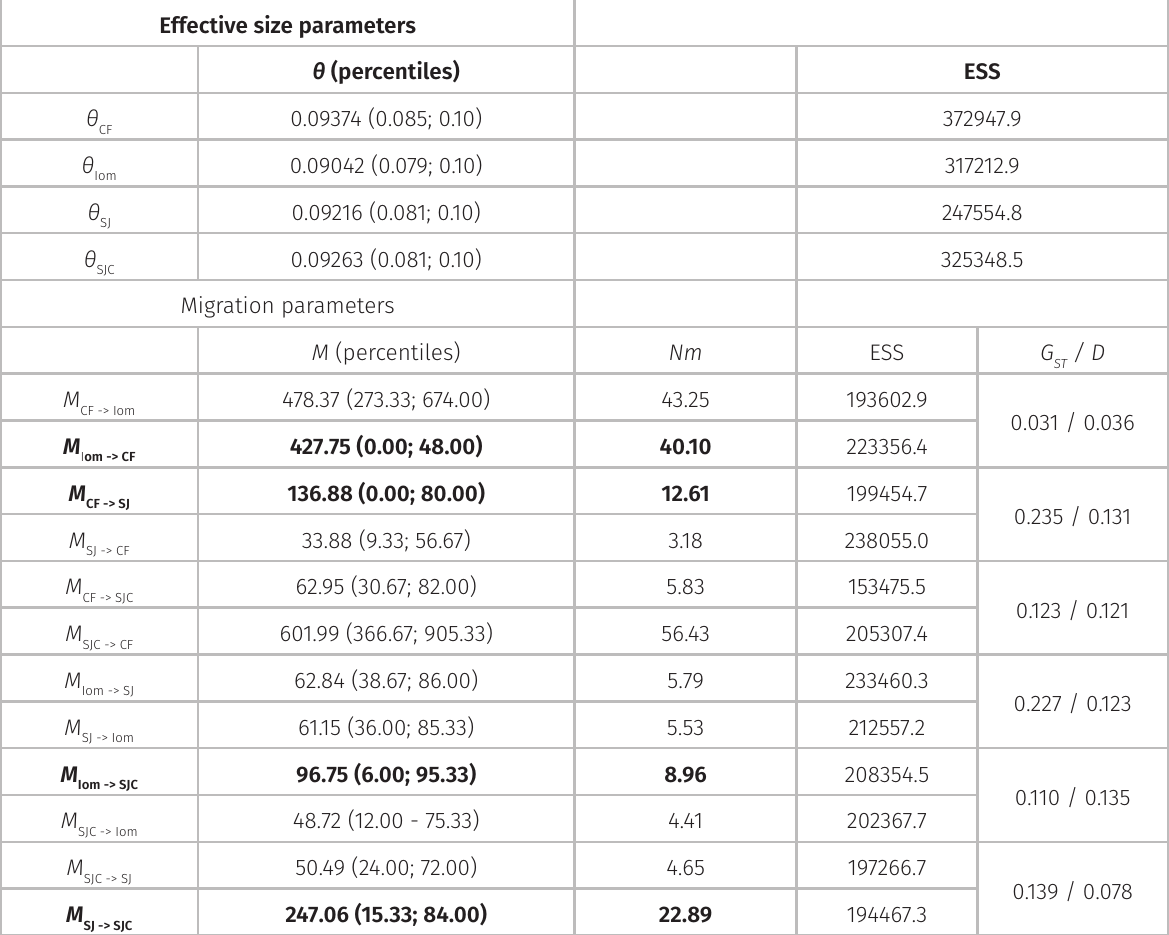
Table III. Scaled effective size ( θ ) of each forest fragment, scaled immigration rate ( M ) and number of migrants per generation ( Nm ), based on all nuclear SSR markers. Means after three independent runs. The effective sample size (ESS) determines the confidence of the estimations. Pairwise estimates of G differentiation) are also displayed for each population pair and are independent of the direction of the gene